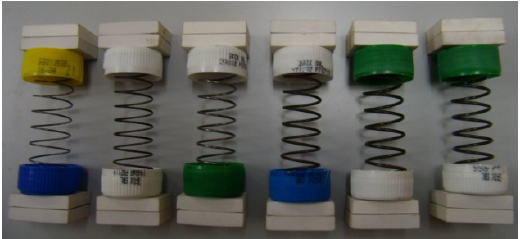
Fig. 4. Test objects used in the experiments. From left to right: 0.8mm, 1.0mm, 1.2mm, 1.4mm,1.6mm and 1.8mm wire diameter.